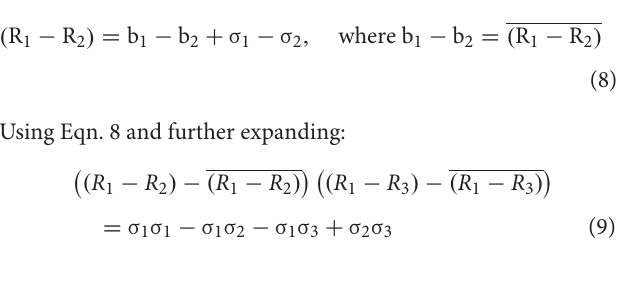
Table 3 . The number of matched buoys at QF = 5 for RGSST5 is 194, which is higher than the same for CC. PDSST finds that 360 buoys, out of 1095, are cloud-free. The RMSD values are 0.36 K and 0.47 K and DC values are 38.3% and 16% for PDSST and RGSST5, respectively. The information gain of PDSST over RGSST5 is ∼ 310%.